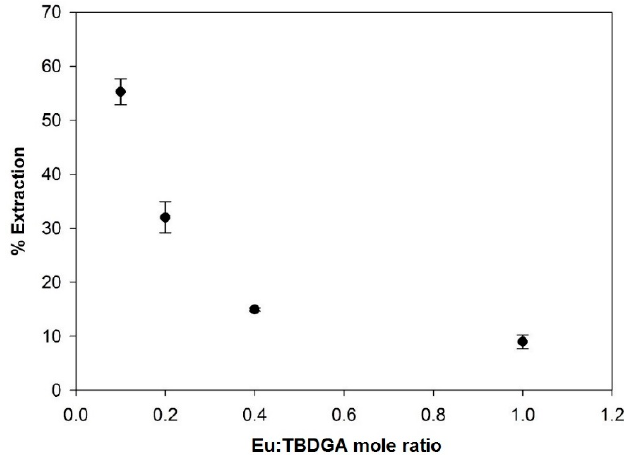
Figure 9. The percent extraction of Eu from a 1000 mg/kg 8 M HCl solution with varied TBDGA concentration in CO 2( l ) modified with 2 mol% 1 ‐ octanol at 34.5 MPa and 23 °C. The TBDGA concentration is listed in Table 3.